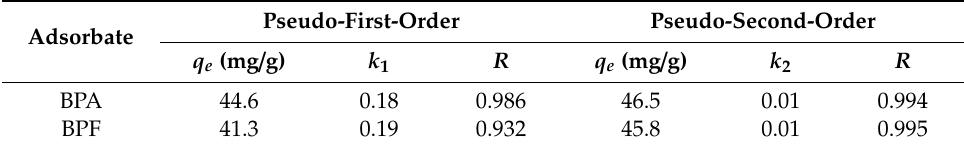
Figure 7. Adsorption kinetics determined for BPA ( a ) and BPF ( b ) on MCGC. Table 2. The kinetic parameters obtained for BPA and BPF adsorption on